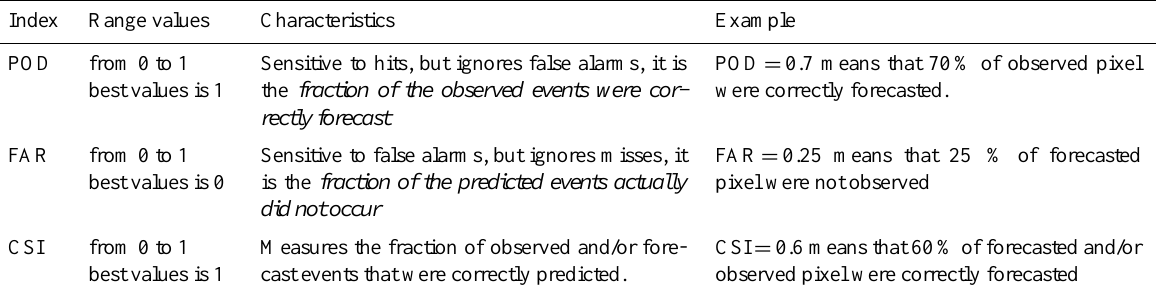
Table 3. Main characteristics of score indexes used to evaluate the HYDRORAD nowcasting algorithm.